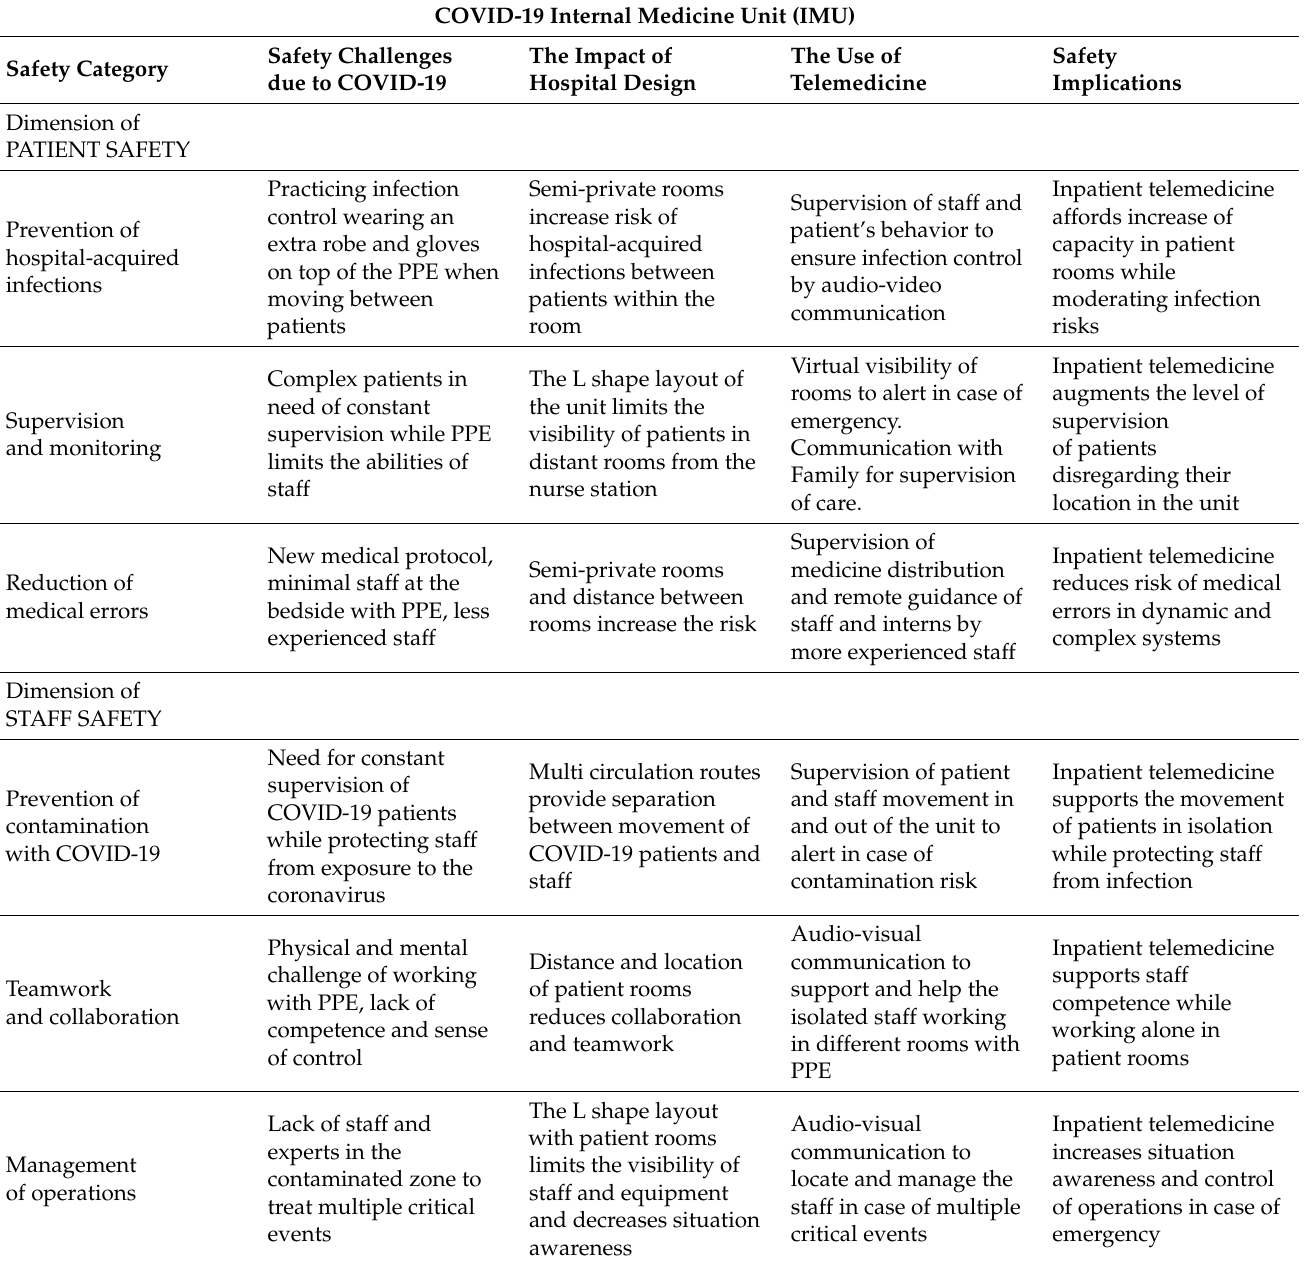
Table 3. The impact of inpatient telemedicine on patient and staff safety in the COVID-19